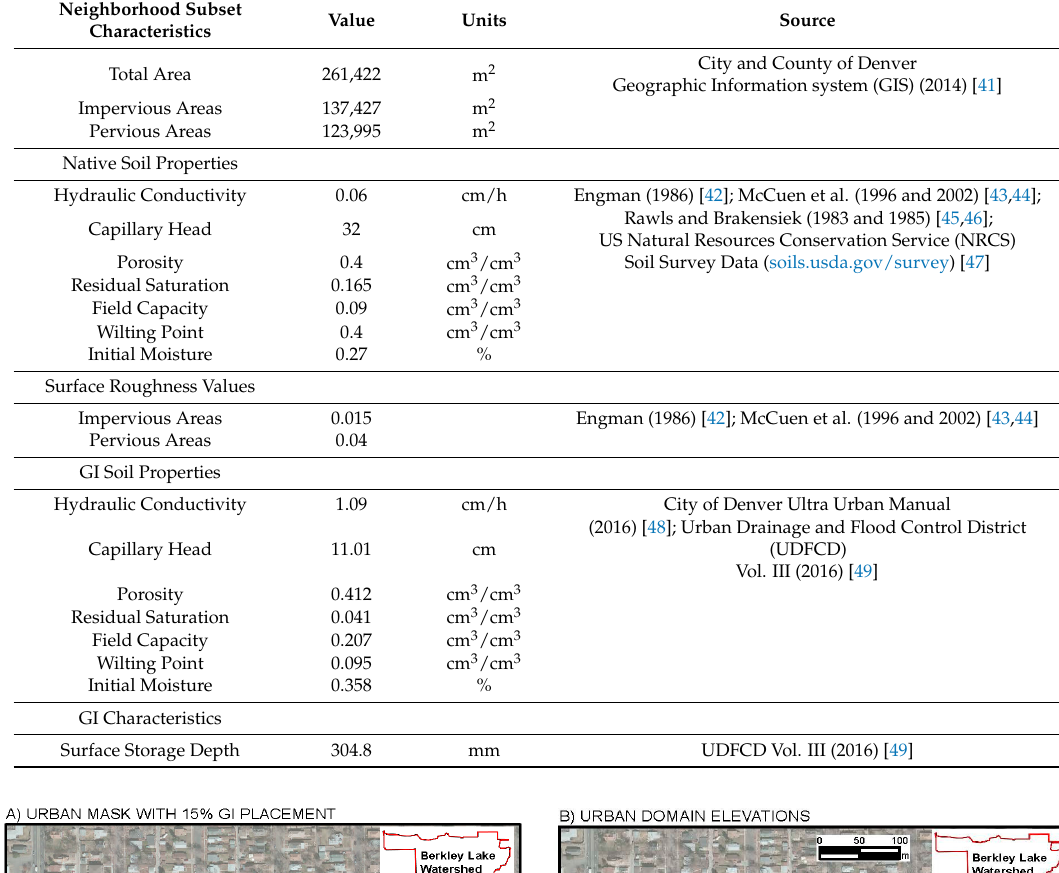
Table 1. Parameter values used in the urban benchmark case: green infrastructure.